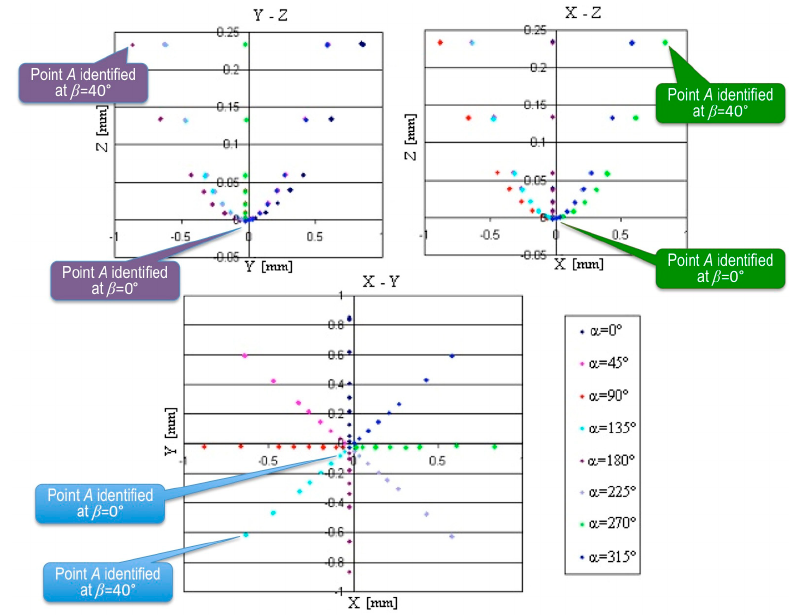
Figure 6. The diagrams x-y , y-z , and x-z of measurement results of point A on the steel surface (Sample 1) at different angles α and β